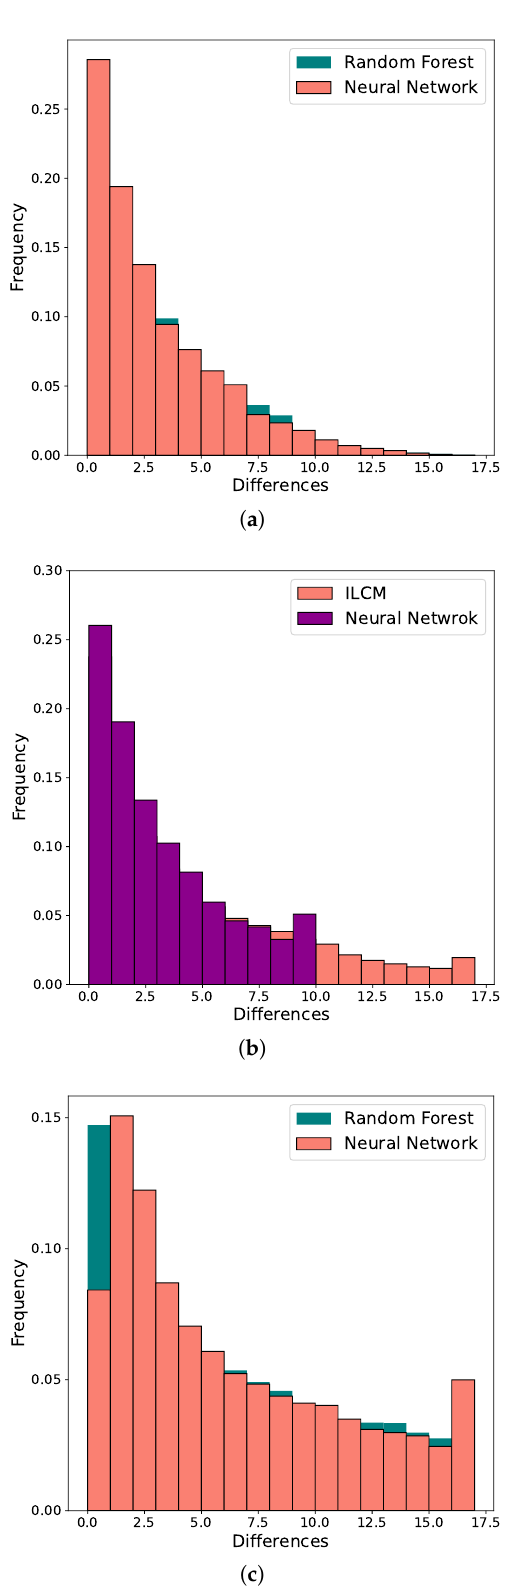
Figure 4. Comparison of absolute errors for Neural Network, Random Forest and ILCM model for frame sizes ( a ) L = 8, ( b ) L = 16 and ( c ) L =